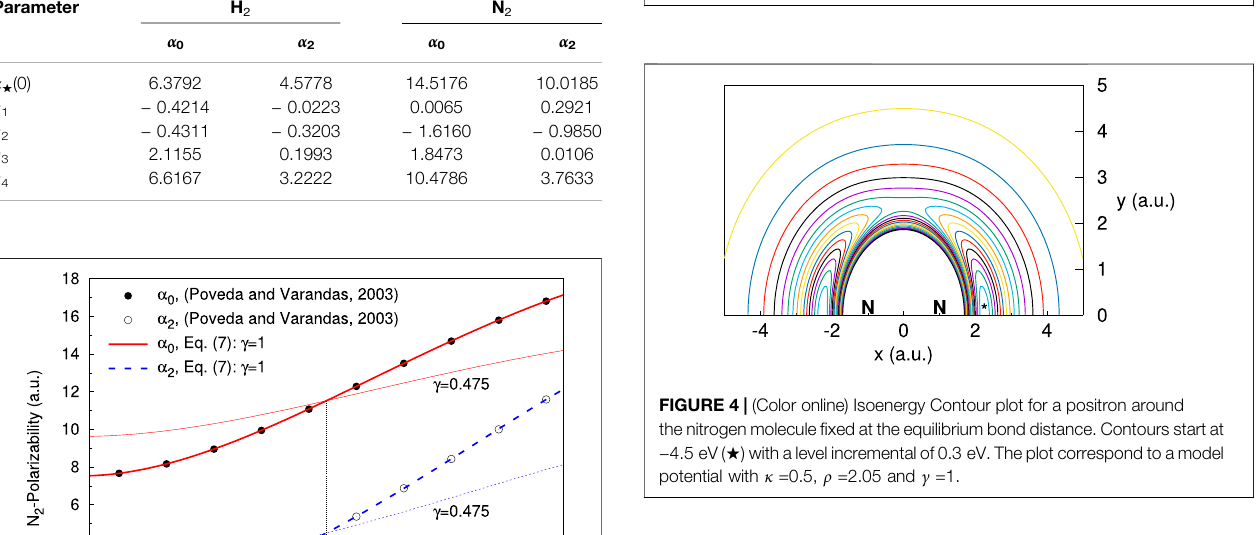
TABLE 2 | Parameters of the polarizabilities, Eq. 7 (in a.u.). Parameter